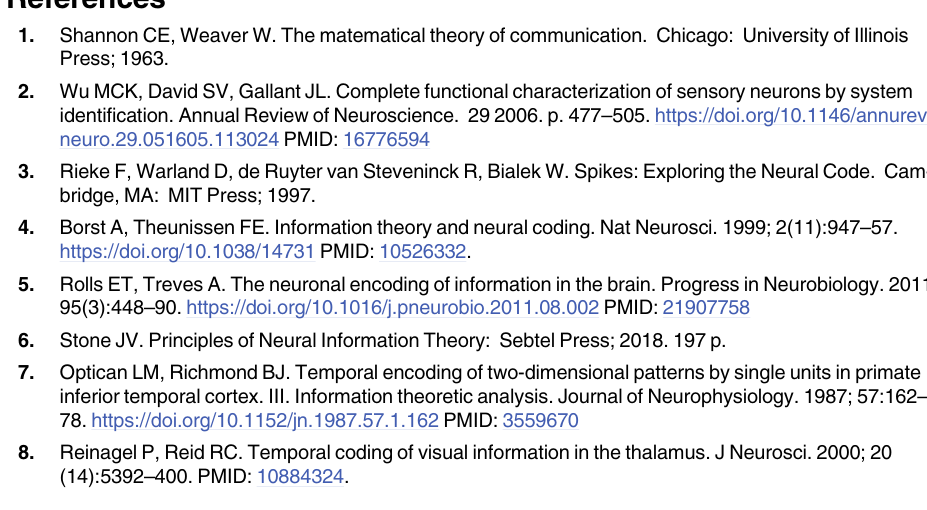
solid line is average obtained for the quartile of neurons with the lowest CII. The vertical plot on the right represents the density of neurons for each value of difference in information at 150